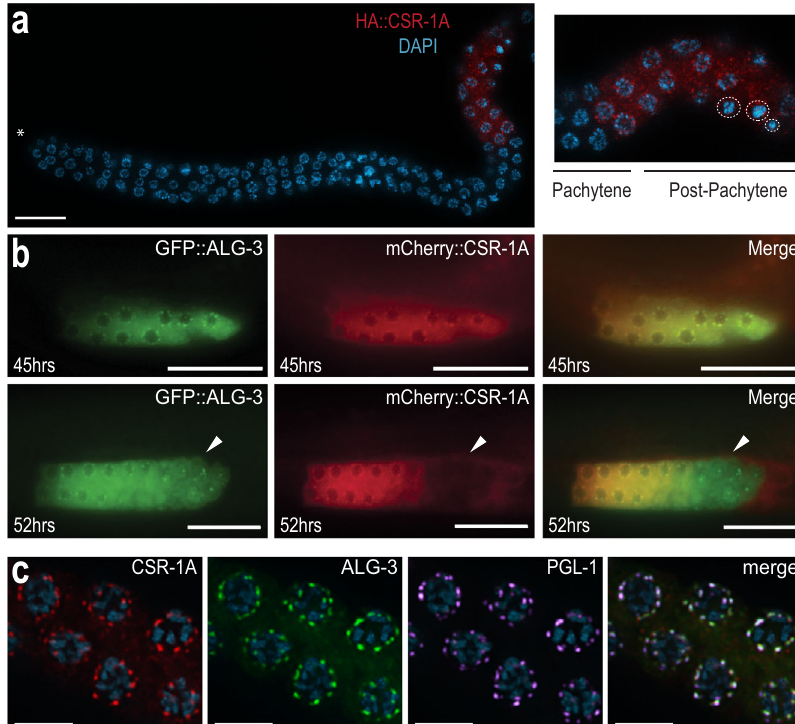
Fig. 2 CSR-1A is expressed in the spermatogenesis region of the germline. a Immuno fl uorescence staining for HA::CSR-1A in dissected L4 hermaphrodite germline, using α -HA. Asterisk indicates distal end. Inset indicates region of cells exiting pachytene and entering post-pachytene where CSR-1A expression is detected. Dashed circles indicate karyosomes. DNA is stained with DAPI, blue. The experiment has been reproduced with at least fi ve individual germlines imaged for each strain. Scale bar, 15 μ M. b 3xFLAG::GFP::ALG-3 (left), 3xHA/mCherry::CSR-1A (middle), and merge (right) at 45-(early L4 stage) or 52-h (young adult stage) post-L1 arrest. White arrows indicate region of secondary spermatocytes. At least fi ve individual germlines were imaged for each strain and condition. Scale bars, 25 μ M. c Immuno fl uorescent staining of a 2xHA::mCherry::CSR-1A; GFP::3xFLAG::ALG-3 dissected L4 hermaphrodite germline, using antibodies against HA, FLAG, and PGL-1. The experiment has been reproduced with at least fi ve individual germlines imaged for each strain. Scale bars, 5 μ